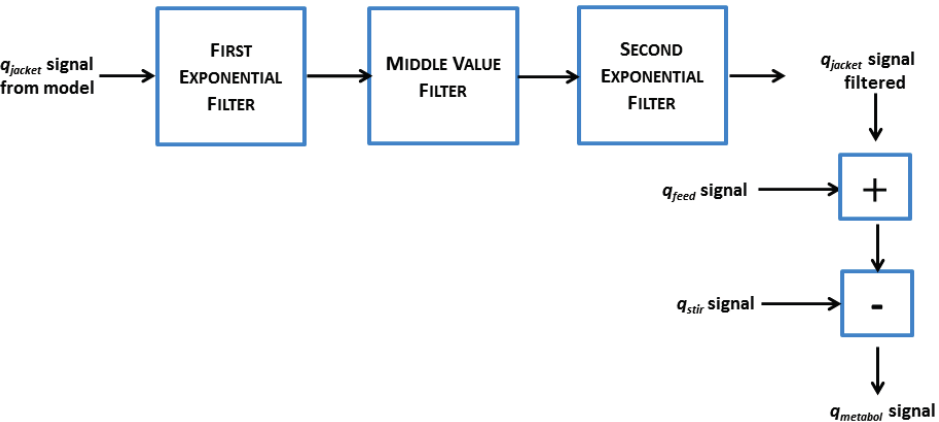
Figure 3. Sequential filtering steps of signal from the calorimetric model before used for monitoring and control of the fed-batch